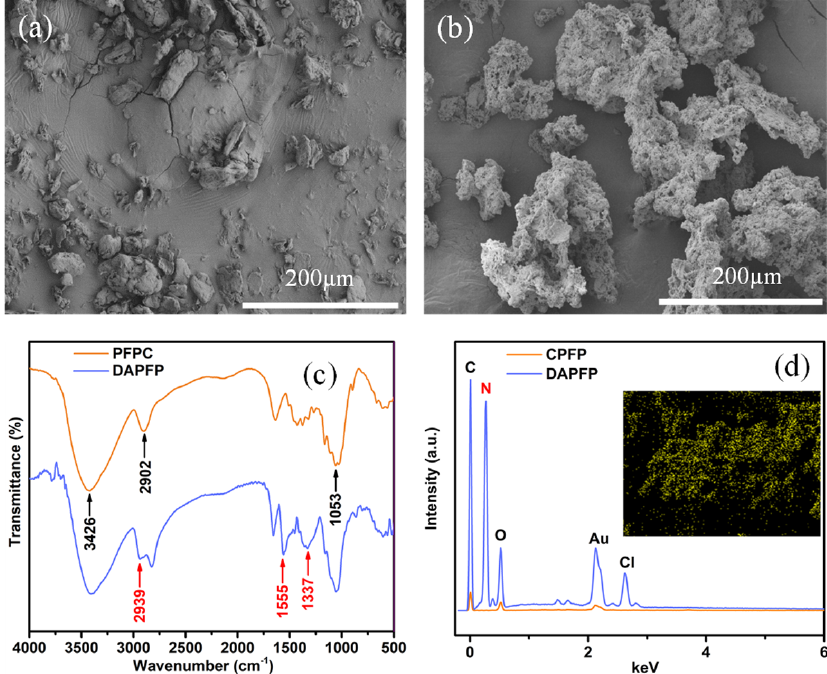
Figure 1. ( a ) SEM images and photographs of CPFP; ( b ) SEM images and photographs of DAPFP; ( c ) CPFP and DAPFP photographs of FT-IR; ( d ) EDS spectrum of CPFP and DAPFP.